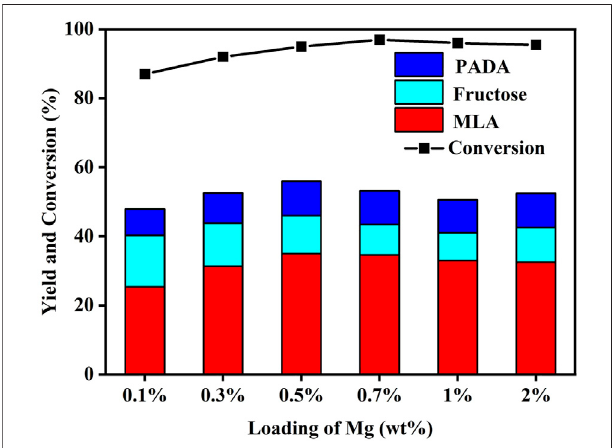
FIGURE 3 | Catalytic performance of Sn- β catalysts and Mg-modi fi ed Sn- β catalysts at moderate temperature. Reaction conditions: glucose, 0.055 g; catalyst, 0.4 g; methanol, 20 ml; N 2 2 MPa; 4 h; 100 ° C.